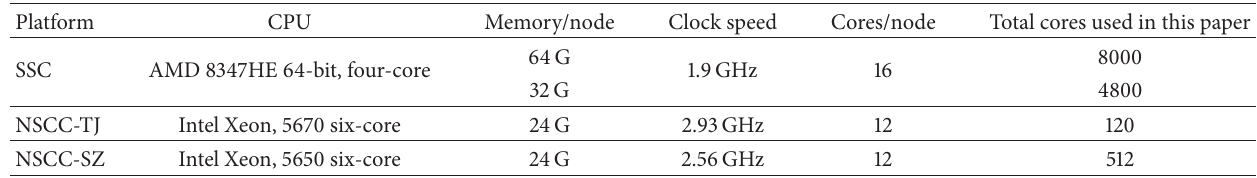
Table 1: Parameters of computation